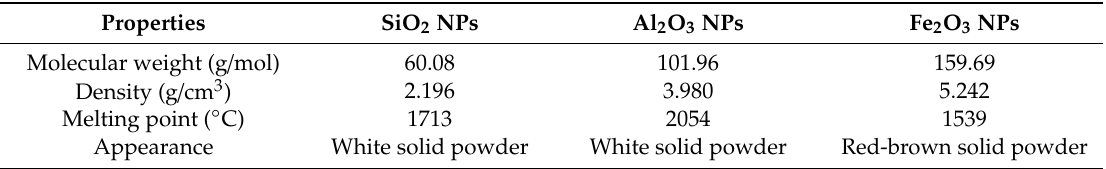
Table 1. Physical properties of the nanoparticles (NPs) used in this